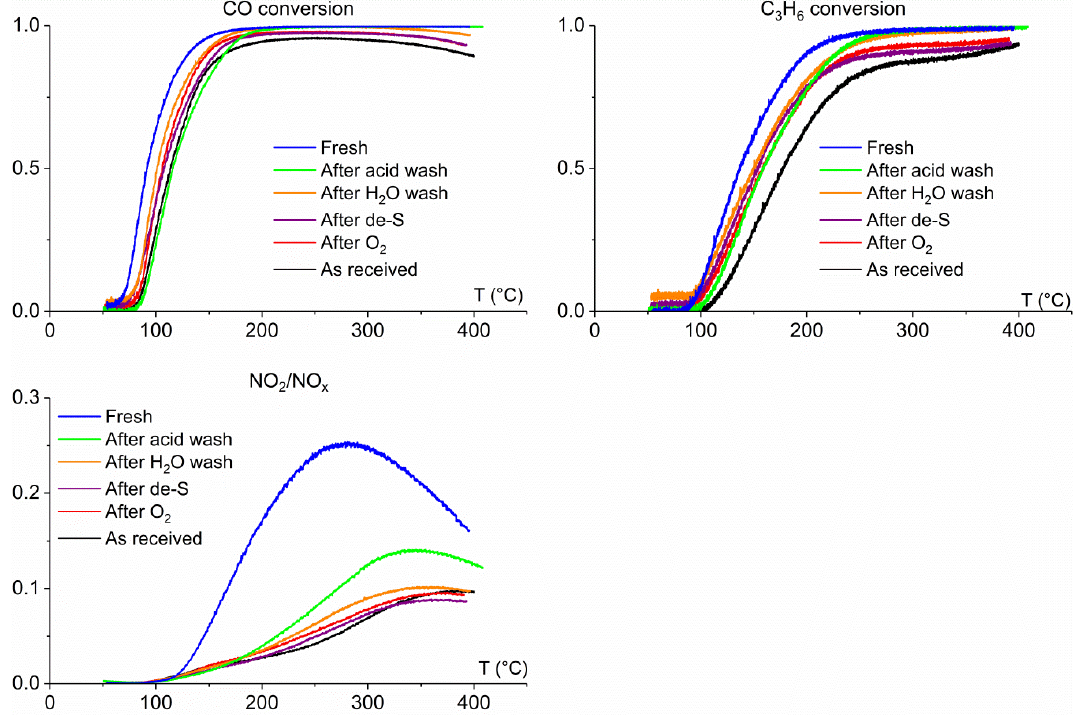
Figure 6. Activity of the samples taken from vehicle-aged catalyst (front and rear) and the cell-aged sample compared to a fresh catalyst of the same type in CO oxidation, C 3 H 6 oxidation, and NO oxidation.